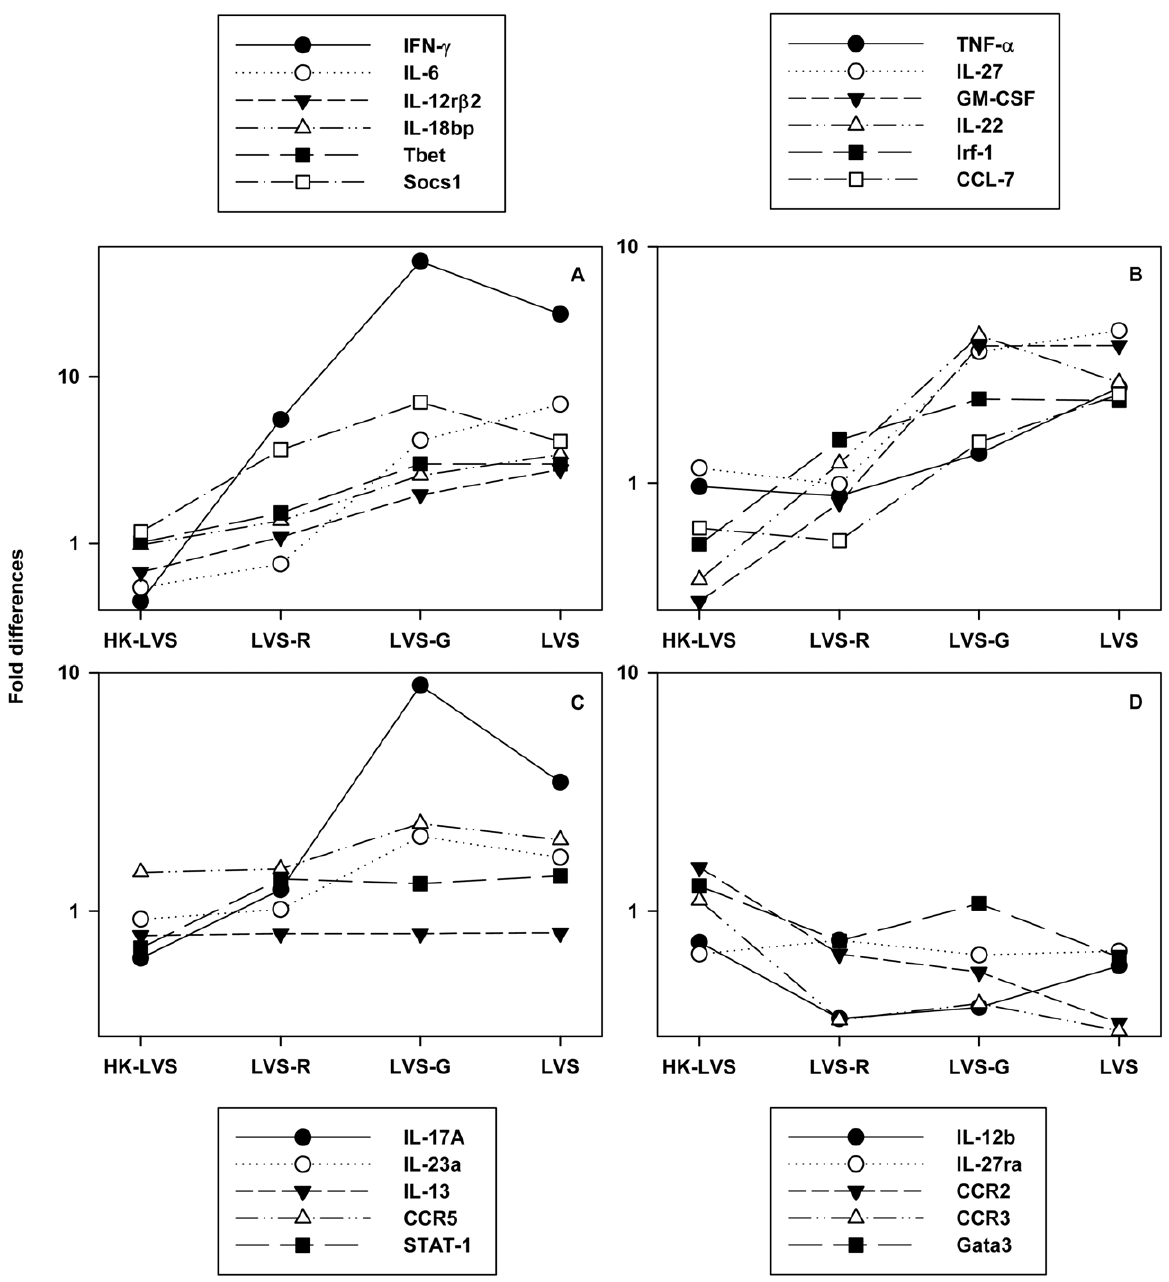
Figure 4. Relationship between relative differences in gene expression and type of vaccine for differentially regulated genes. Data from all four experiments using the full panel of vaccine candidates (Table S2, experiments 4 – 7) are used to provide a graphic representation of the relationship between type of vaccine and relative gene expression. All data were normalized in relationship to endogenous GAPDH standard curves, and values shown are median of the fold differences ( DD Ct) in relationship to naive cells for each type of vaccine, as indicated. Panel A depicts the genes designated as Group 1 in Table 1 (all significant, p , 0.0001); Panel B depicts the genes designated as Group 2 in Table 1 (all significant, p , 0.0001); Panel C depicts the remaining up-regulated genes not included in Groups 1 or 2 of Table 1 (IL-17A, IL-23a, CCR5, and STAT-1 significant with p , 0.05, but IL-13 not significant; see Table S4 for exact p values); and Panel D depicts down-regulated genes (all non-significant; see Table S4 for p values). The corresponding legends are shown immediately above or immediately below each